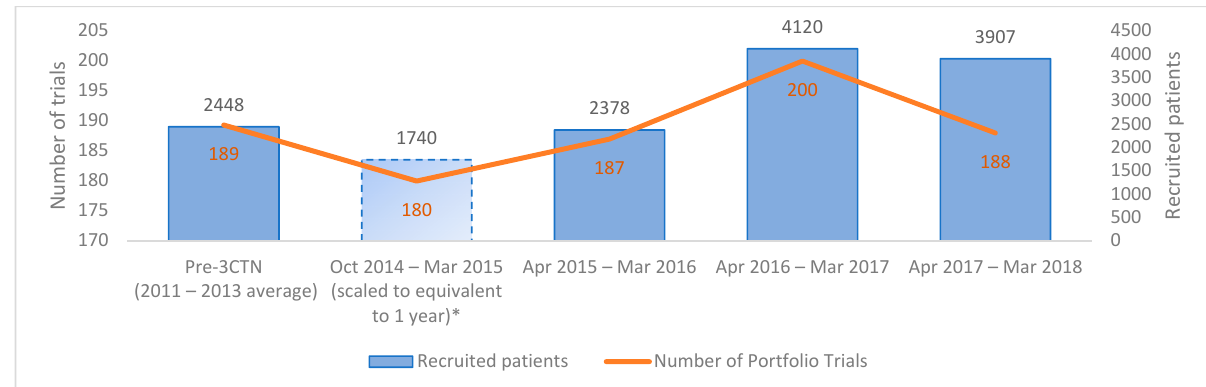
Figure 2. Number of active Portfolio trials and patients recruited at adult member institutions. * Member institutions reported recruitment data as of 1 October 2014.